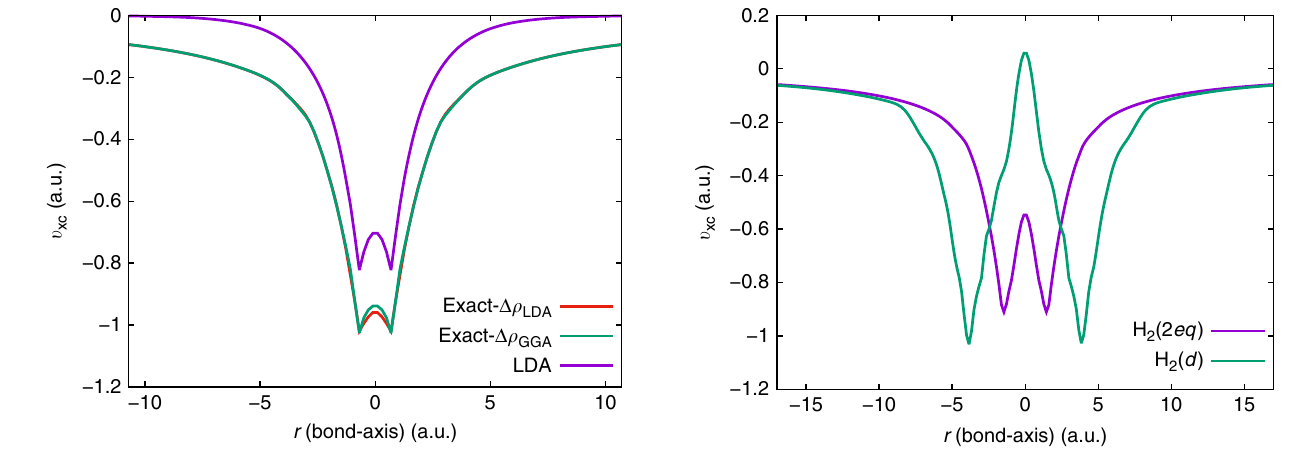
is provided for xc